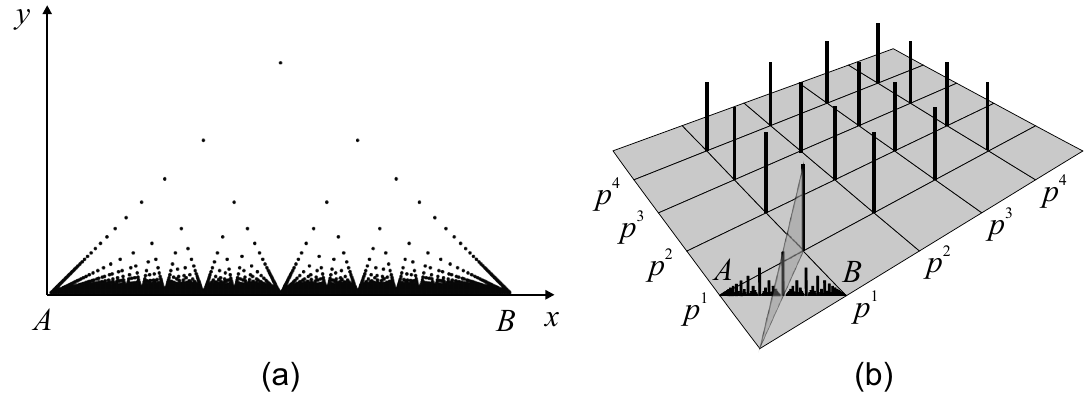
Figure 3 . (a) Riemann function, (b) Riemann function constructed by the Euclid Orchard.